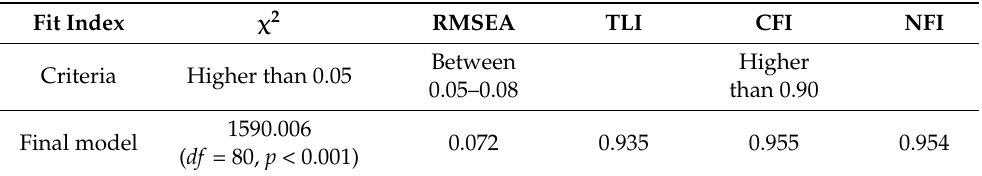
Table 2. Goodness of fit of the Structural Equation Model.